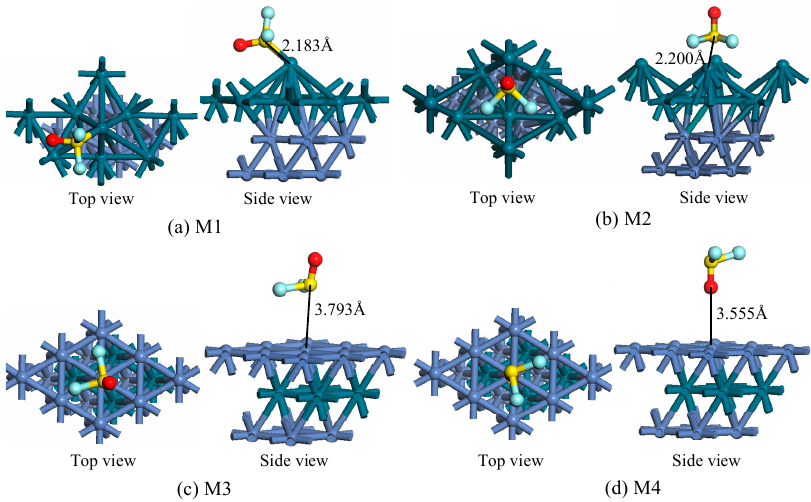
Table 1. The adsorption parameters of SOF 2 adsorbed by Ni(111), Pd-Ni(111), and Ni-Pd-Ni(111) surfaces.